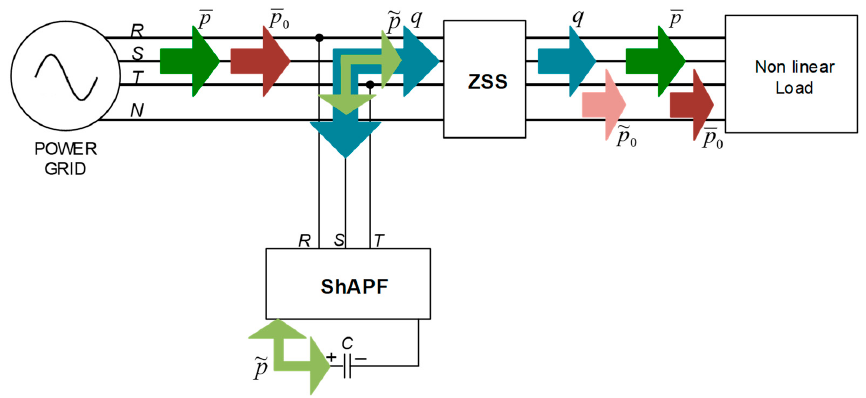
Figure 6. p-q theory power components using the HyShAPF. Figure 6. p - q theory power components using the HyShAPF.